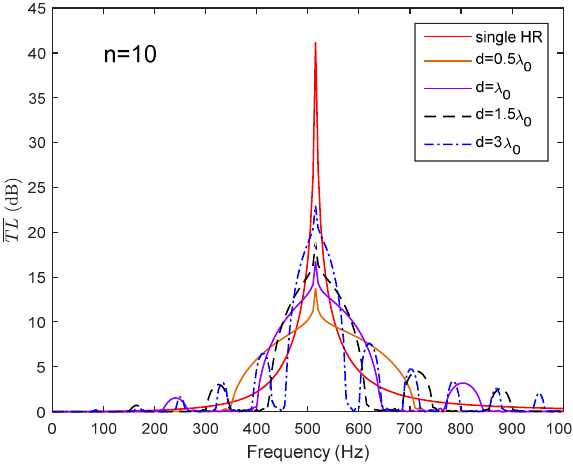
Figure 5. The noise attenuation band of a periodic HR array due to coupling of Bragg reflection and HR’s resonance frequency.